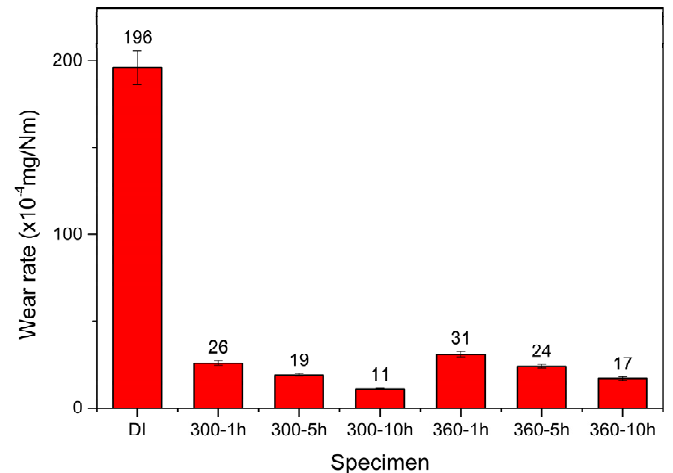
Figure 11. Comparison of wear rates among the specimens after wet wear